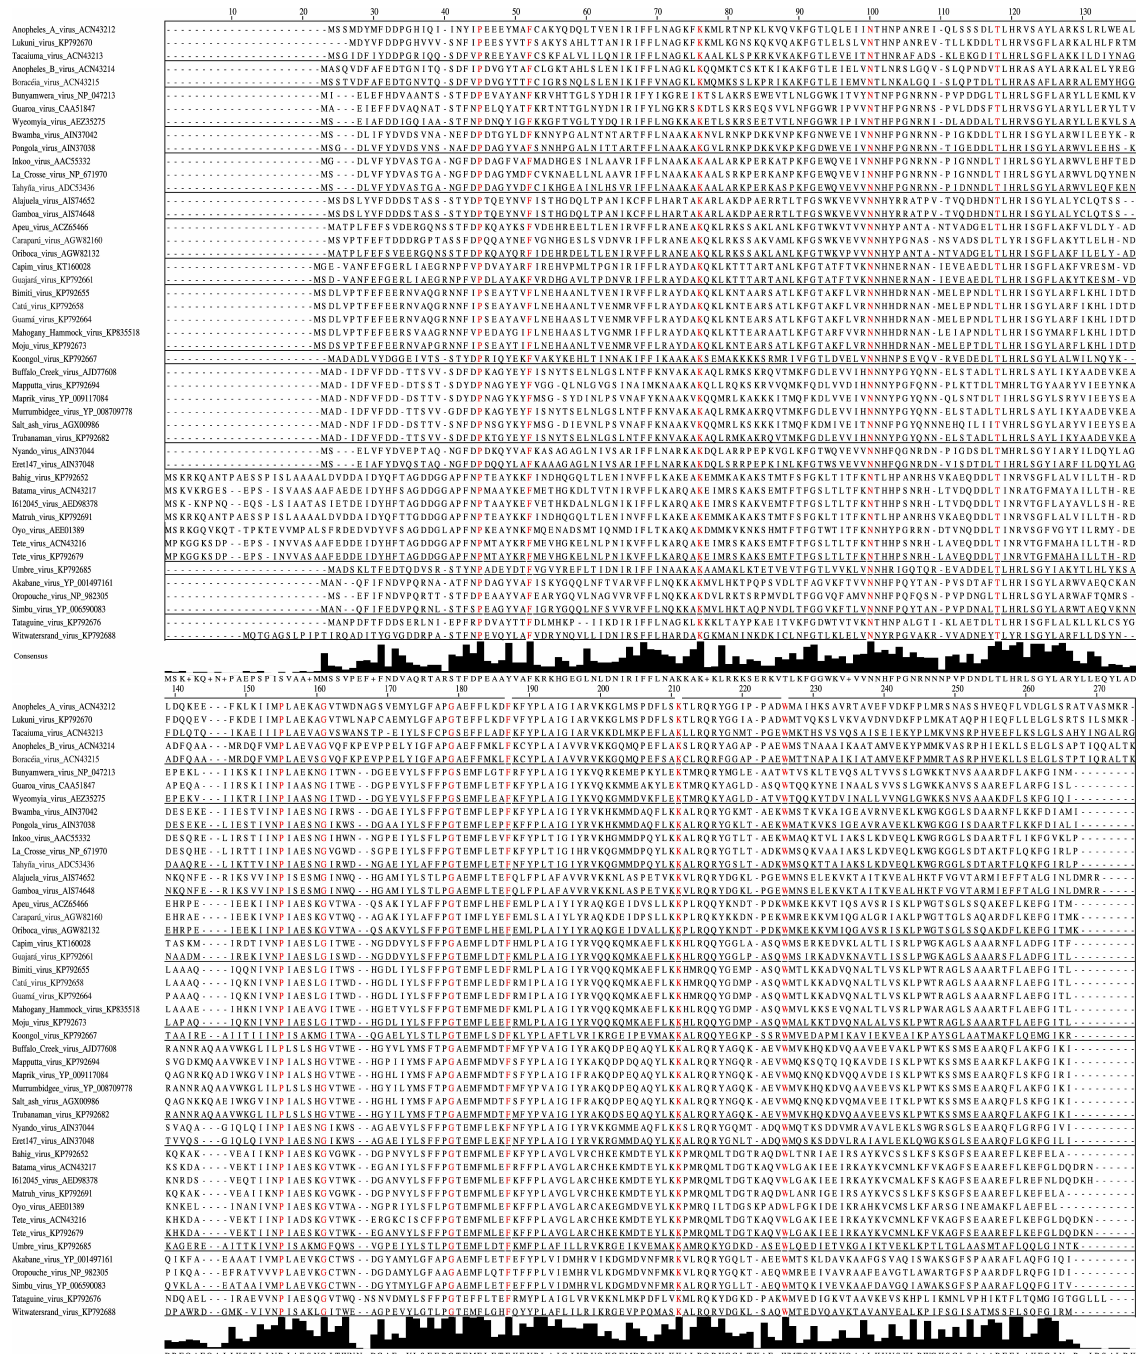
Figure 2. Amino-acid alignment of orthobunyaviral nucleocapsid protein sequences. Alignment was performed on 118 nucleocapsid sequences belonging to different orthobunyaviruses using the Clustal algorithm with default settings as implemented in Jalview 2.9 [76], followed by hiding all but selected representatives of the serogroups. Sites that are strictly conserved among all aligned sequences are depicted in red. Consensus histograms, calculated for all aligned sequences, represent proportions of sites matching corresponding positions of the consensus